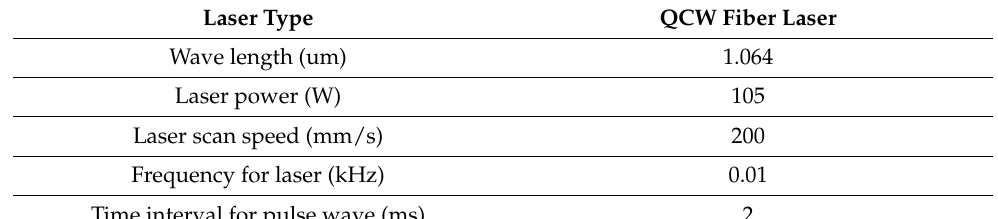
Figure 1. Laser welding research platform and fixture.